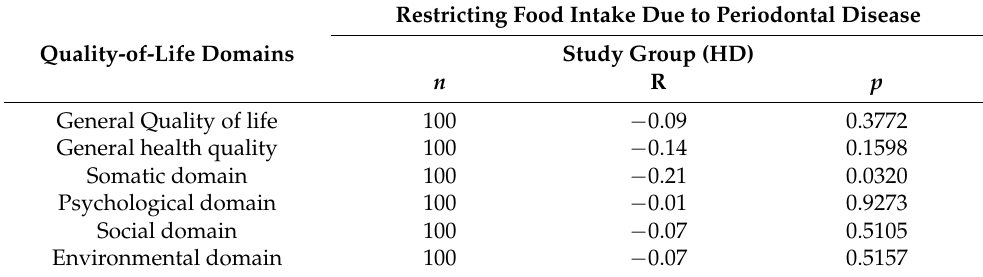
Table 9. Quality of life and limiting food intake due to periodontal disease in the study group (HD).